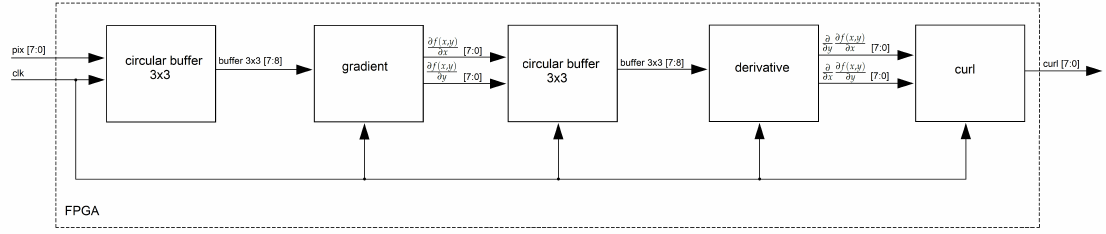
Figure 12. FPGA architecture for the “curl” unit.